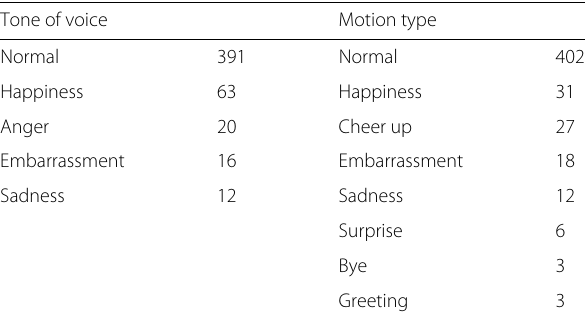
Table 2 Number of selections of various tones of voice and motions for characters by university